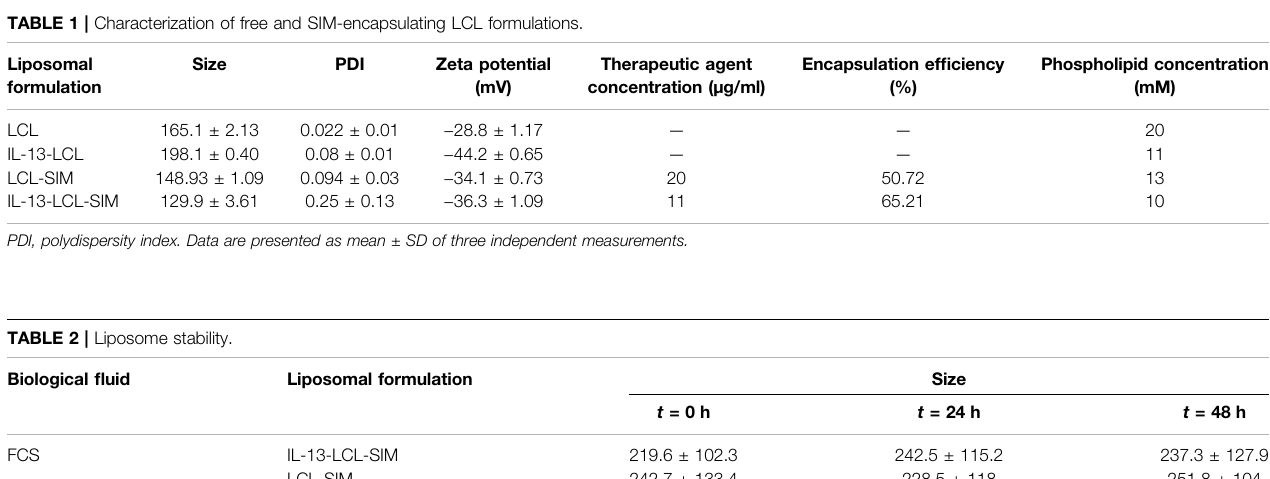
TABLE 1 | Characterization of free and SIM-encapsulating LCL formulations. Liposomal formulation